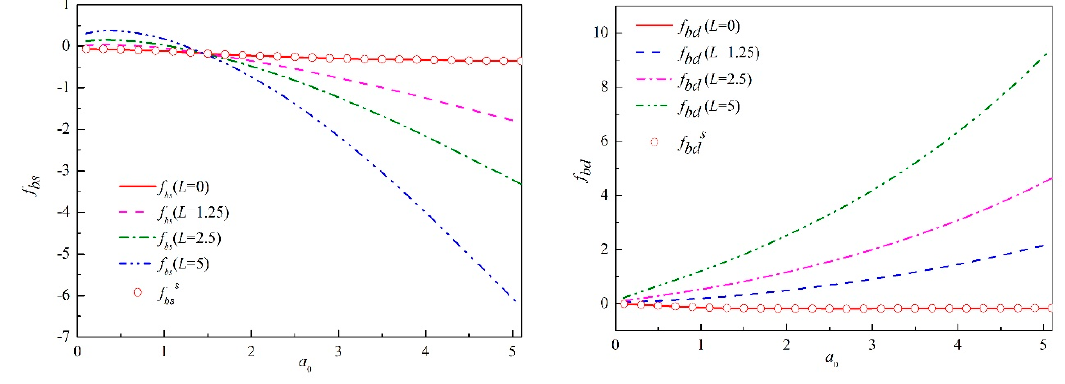
Figure 2. Verification of the foundation base.